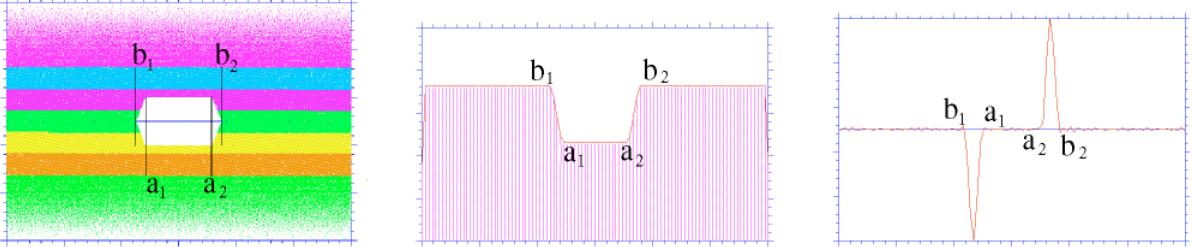
FIG. 15. (Color) Phase space, line density, and space-charge voltage for single